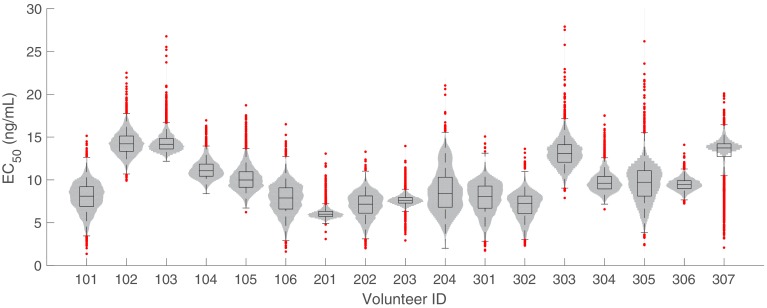
The marginal posterior distributions of the individual parameter of EC50 (half-maximum effective PQP concentration) for all 17 volunteers.The violin plots (gray area) show the distributions of 5000 posterior samples. Box plots show the 25%, 50% (median) and 75% quantiles with outliers indicated by red dots. Relevant details of the individual parameter are provided in the Materials and methods in the main text.